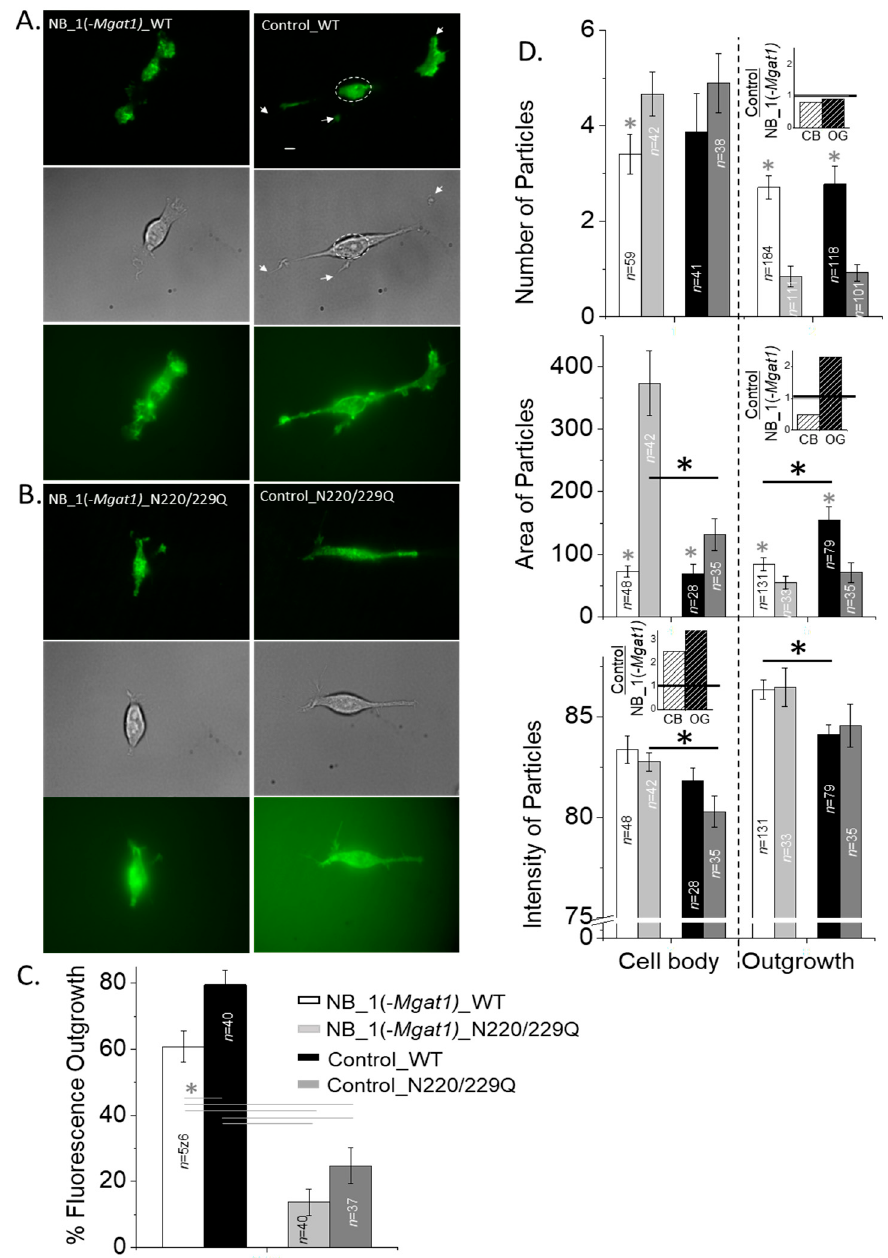
Figure 5. N-Glycosylation processing modified the spatial arrangement of Kv3.1b protein-containing particles in subdomains of the cell membrane. Representative micrographs of glycosylated (WT) ( A ) and unglycosylated (N220/229Q) ( B ) Kv3.1b proteins expressed in NB_1(-Mgat1) (left panels) and control (right panels) cells acquired in TIRF (upper panels), DIC (middle panels) and wide-field (lower panels) modes. Representative scale bar (5 µM) was similar for all acquired images. The dashed circle denotes the cell body and the projections from the cell body represent the outgrowths. ( C ) Percent fluorescence in the outgrowth of parental and N-glycosylation mutant cells lines stably expressing glycosylated (WT) and unglycosylated (N220/229Q) Kv3.1b proteins. Data are presented as the mean ± SEM and were compared by one-way ANOVA (* p < 0.03). n represents the number of cells analyzed. ( D ) Number (top panel), area (middle panel) and mean intensity (bottom panel) of particles in cell body and outgrowth of NB_1(-Mgat1) and control (NB_1) cell lines expressing glycosylated (WT) and unglycosylated (N220/229Q) Kv3.1b proteins. Insets represent differences in the particle parameters due the type of N-glycan attached to the Kv3.1 protein in cell body and outgrowth. Graphs denote mean ± SEM and were compared by Student’s t-test ( p < 0.05). (*) denotes a comparison between glycosylated and unglycosylated Kv3.1b in the same cell line and (*) represents a comparison between either glycosylated or unglycosylated Kv3.1b a cell line. n denotes the number of particles examined.